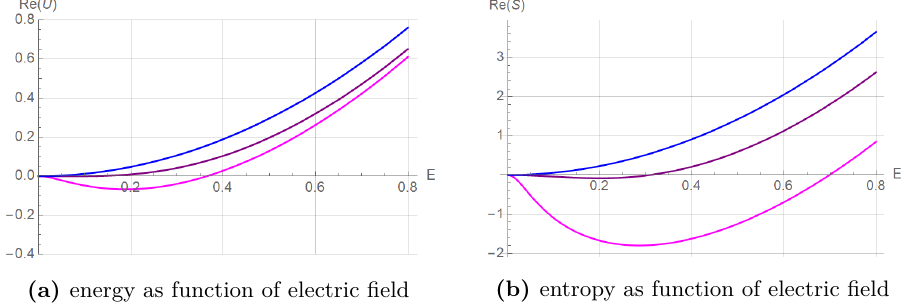
Figure 2. When turning on a flux in the static patch, the Euclidean partition function of the charged scalar becomes complex. Using (2.28) we calculate the finite parts of the energy U and entropy S as function of the electric field E . In the above plots, we display the real parts, where the value at zero field has been subtracted. From magenta to blue we have m = 0 . 2 , 0 . 5 , 1 . For sufficiently large mass, these quantities are monotonic as function of E . For smaller masses 4 m 2 . 1 this is not the case. In section 4, we will find a similar effect in the Schwinger pair production rate. The low mass range is excluded by the FL bound [37].